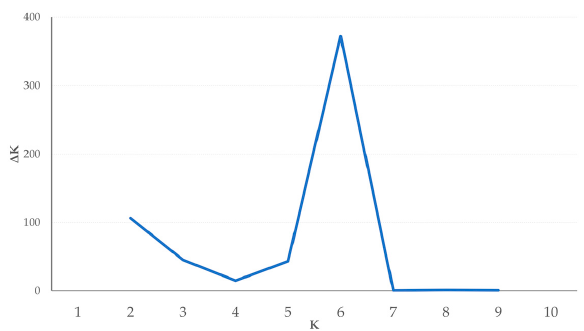
Figure 4. The results of the Principal Coordinates Analysis (PCoA) of nine accessions of Avena macrostachya Bal. ex Cross. et Durieu based on sequence-related amplified polymorphism (SRAP) markers.